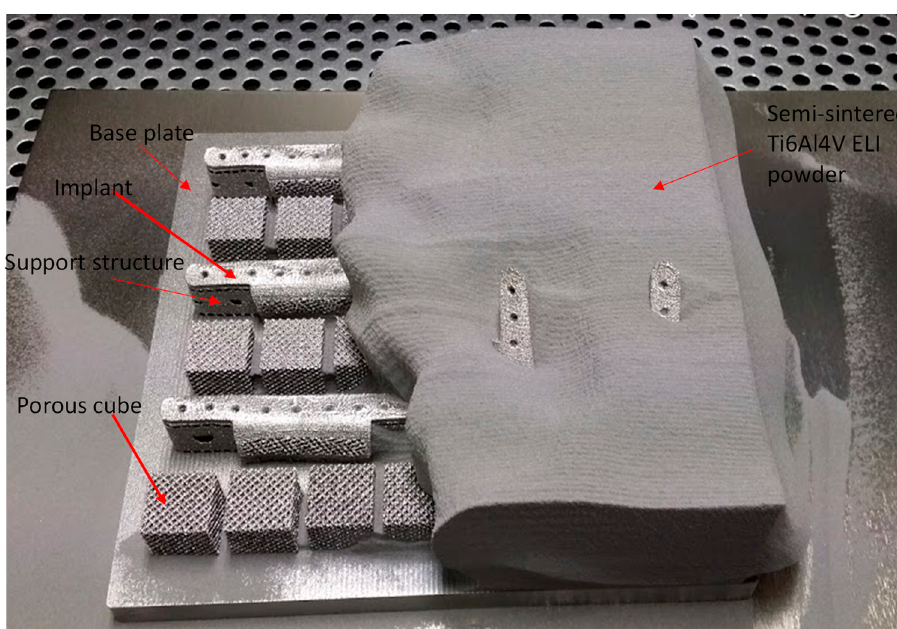
Figure 5. Fabrication of titanium goat implants with dode thick cube structures.